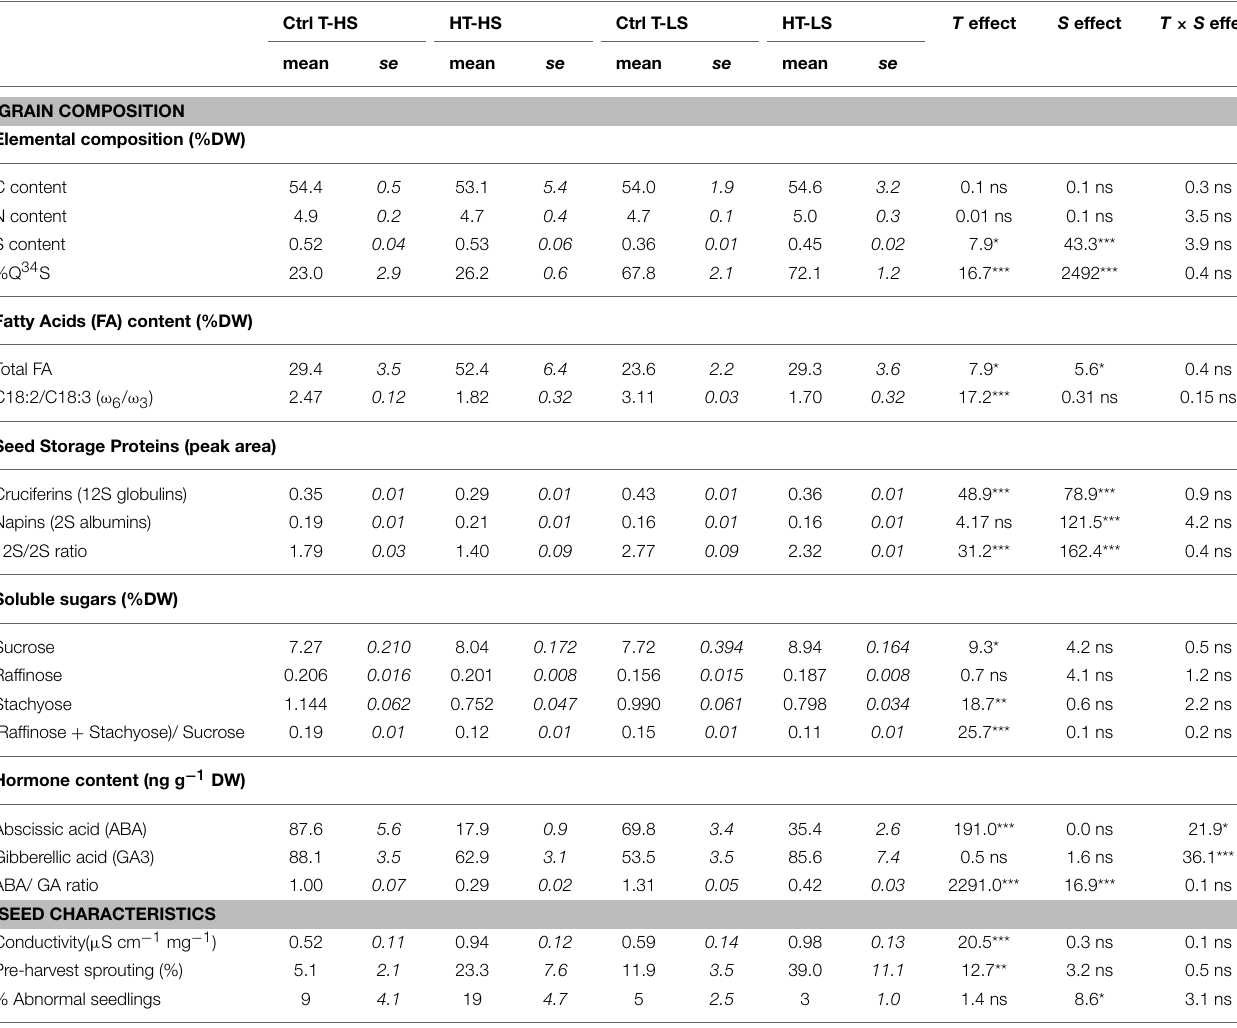
TABLE 2 | Mean values of measured variables related to grain composition and seed germination